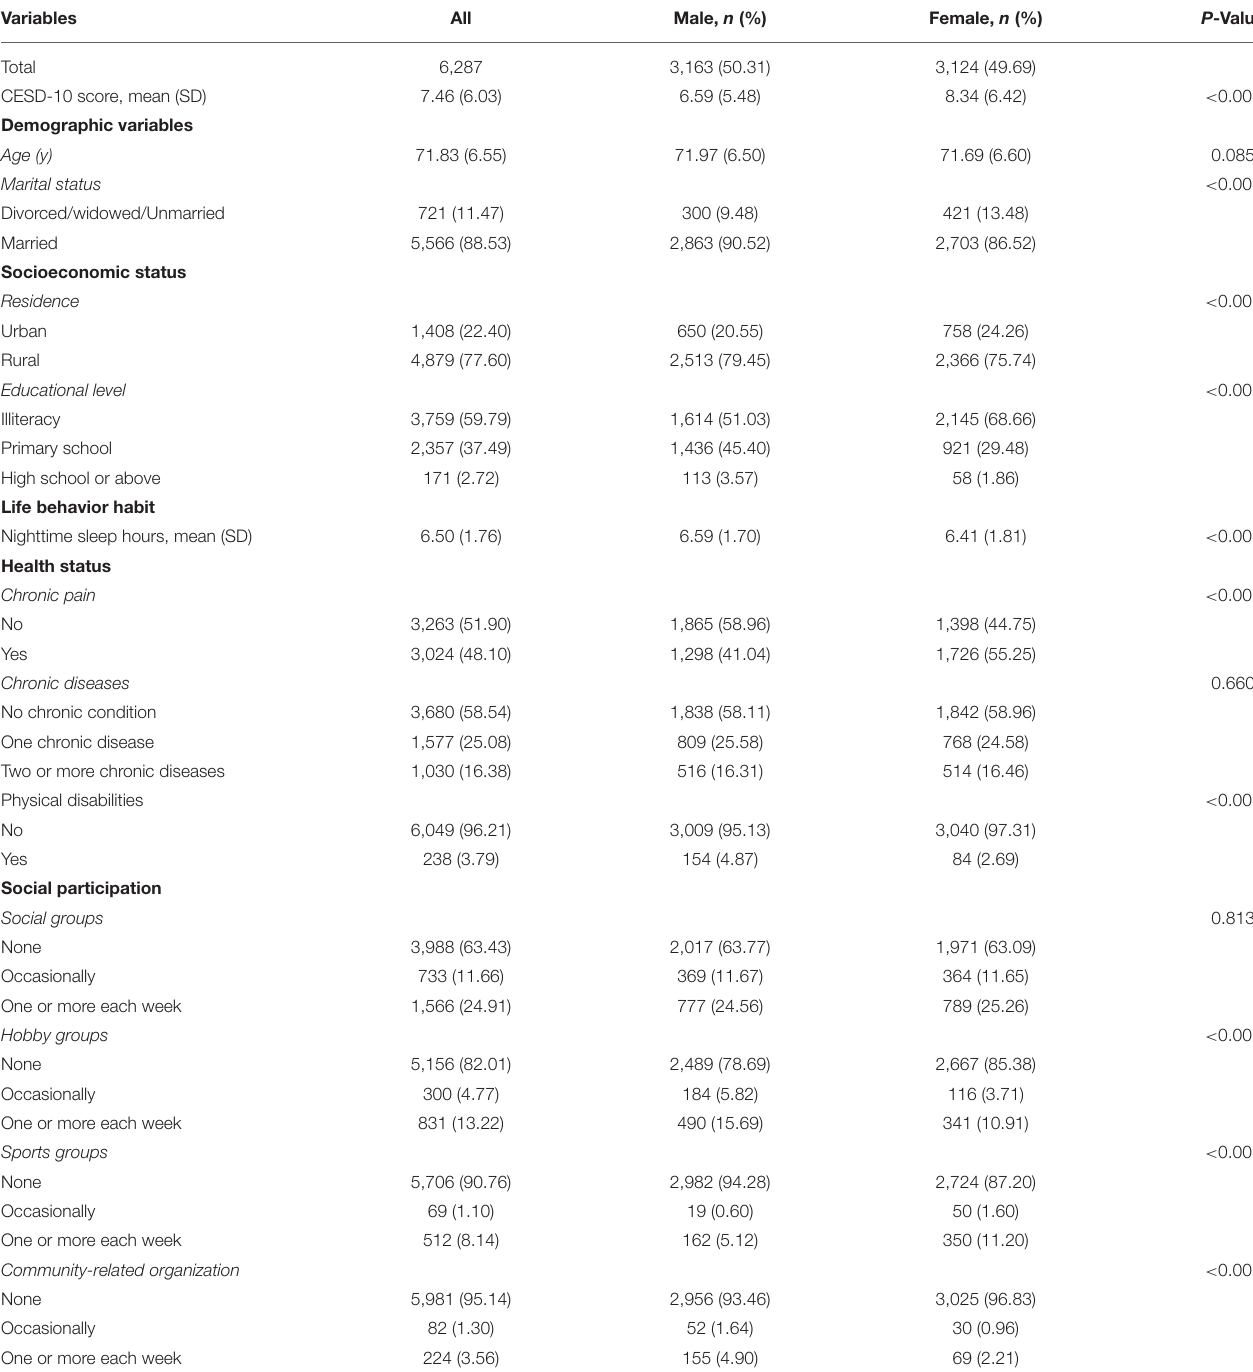
TABLE 1 | Participants’